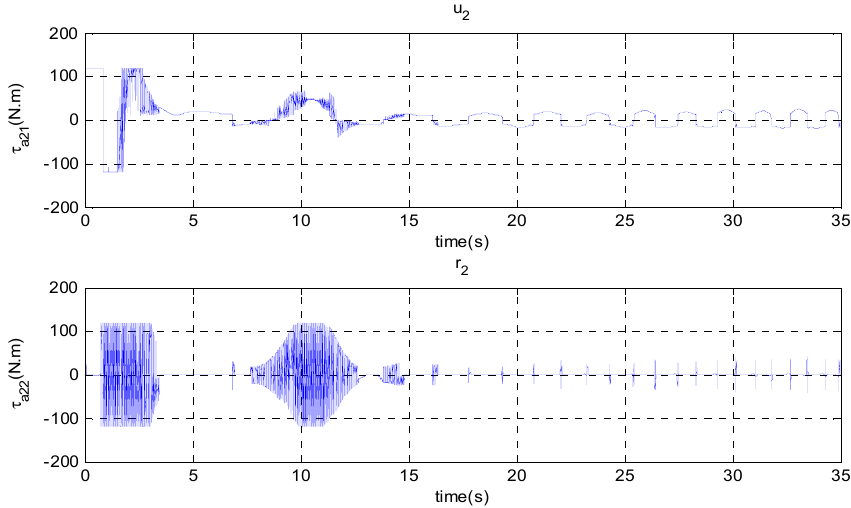
Figure 8. Applied input control of the second follower in Example 1.